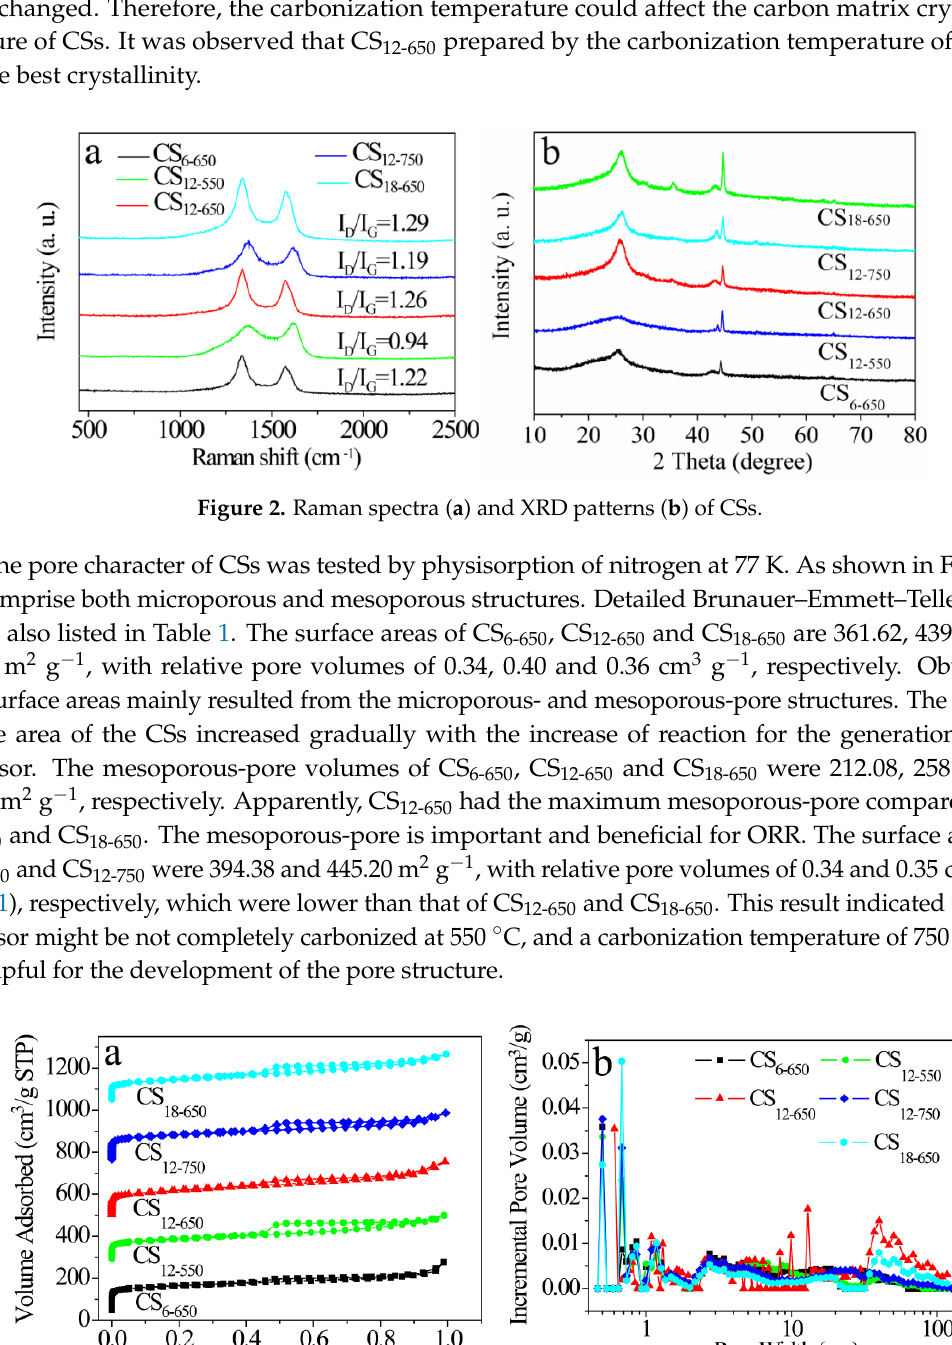
Figure 2. Raman spectra ( a ) and XRD patterns ( b ) of CSs.